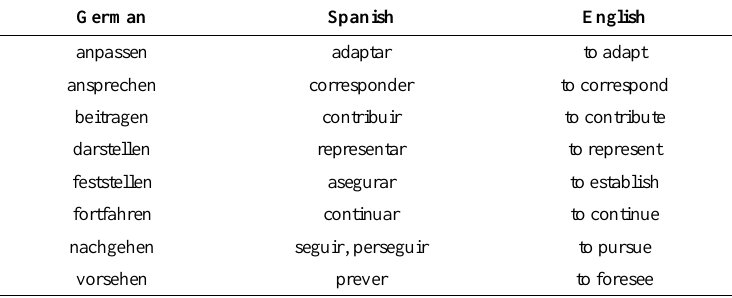
Table 1. Some of the verbs of this type frequent in medical-pharmaceutical